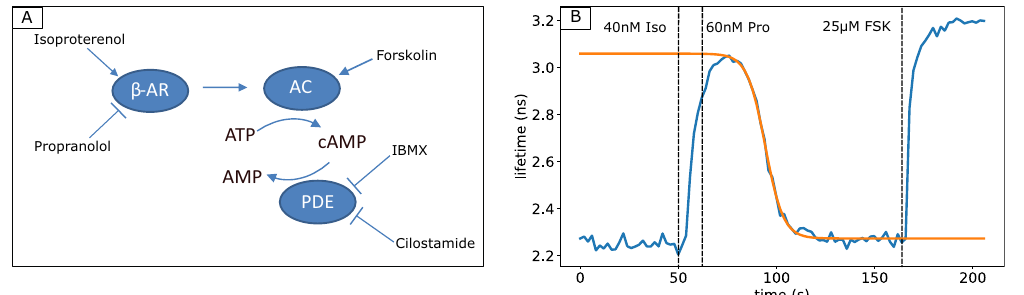
Figure 6. Assessing receptor mediated cAMP pathway. ( A ) Overview of the β-adrenergic receptor signaling pathway and agents used to affect cAMP production and breakdown. ( B ) Donor fluorescence lifetime changes of the Epac-S H189 sensor (blue line) in a single HeLa cell after stimulation of the β-adrenergic receptor with the agonist isoproterenol (40 nM) and subsequent blocking with the antagonist propranolol (60 nM). Forskolin (FSK) (25 µM) is added for calibration. Also shown is a logistic fit to estimate the cAMP breakdown time